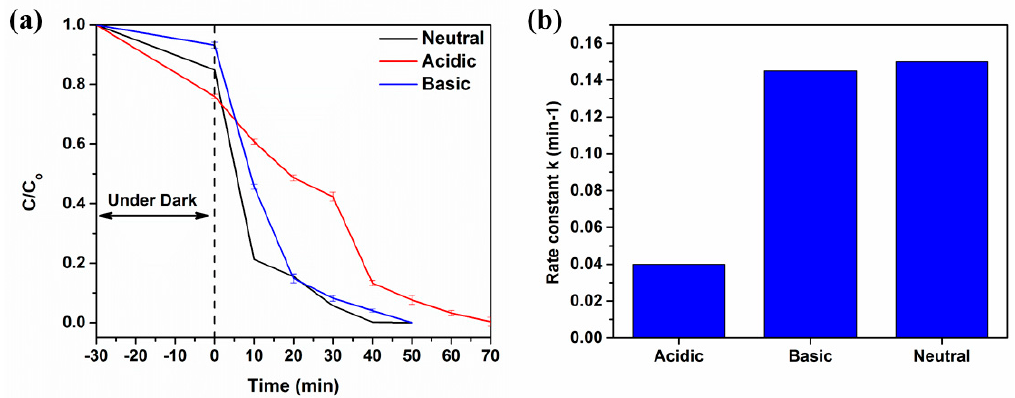
Figure 7. Effect of pH on MB dye decolorization for 5% AgFeO 2 /rGO/TiO 2 sample: ( a ) Relative concentration of MB dye decolorization with time and ( b ) rate constants calculated . Table 1. Decolorization time for MB at various pH of Dye Medium.